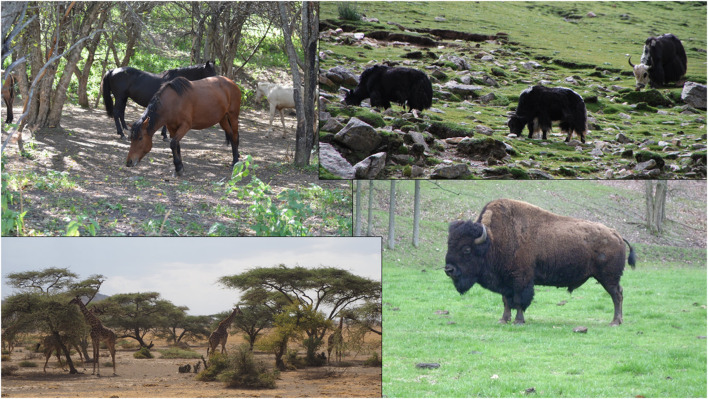
From top left: (1) Photo of horses consuming wild apples in the Tien Shan apple forests of Kazakhstan, photo taken by Artur Stroscherer and Martin Stuchtey. (2) Yaks grazing in Tibet have significant ecological impacts, photo by lead author. (3) Giraffes near the Olduvai Camp in Tanzania browsing on Acacia trees, photo taken by Yiming Wang. (4) Bison in Missouri on a heavily grazed field of herbaceous annuals, most of which are well adapted to heavy herbivory and disturbed ecosystems, photo by lead author.